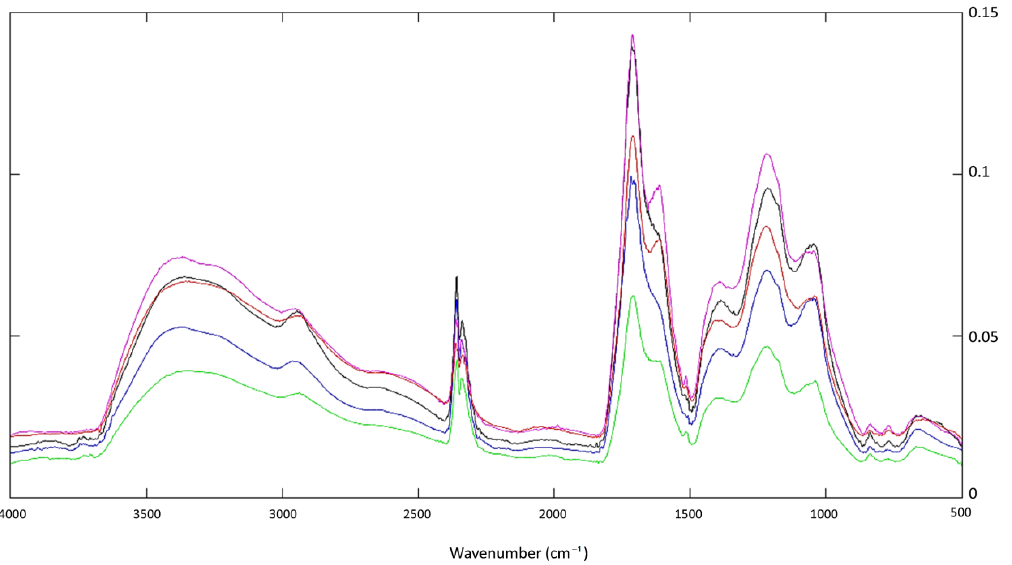
Figure 4. Fourier-transform infrared spectroscopy–attenuated total reflectance (FTIR-ATR) spectra of all PPL-DOM SAS samples. Black: SAS 1A B; Blue: SAS 1A S; Green: SAS 2A B; Magenta: SAS 2A S; Red: SAS 1B M .